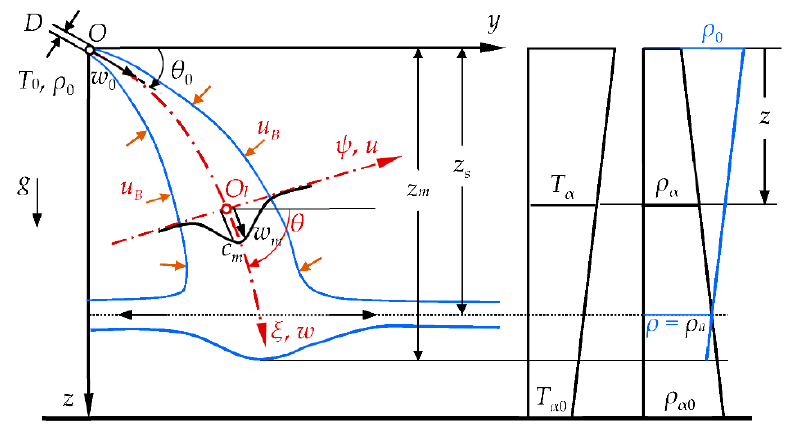
Figure 2. Configuration of the flow and mixing field of an inclined buoyant jet in a stratified environment.